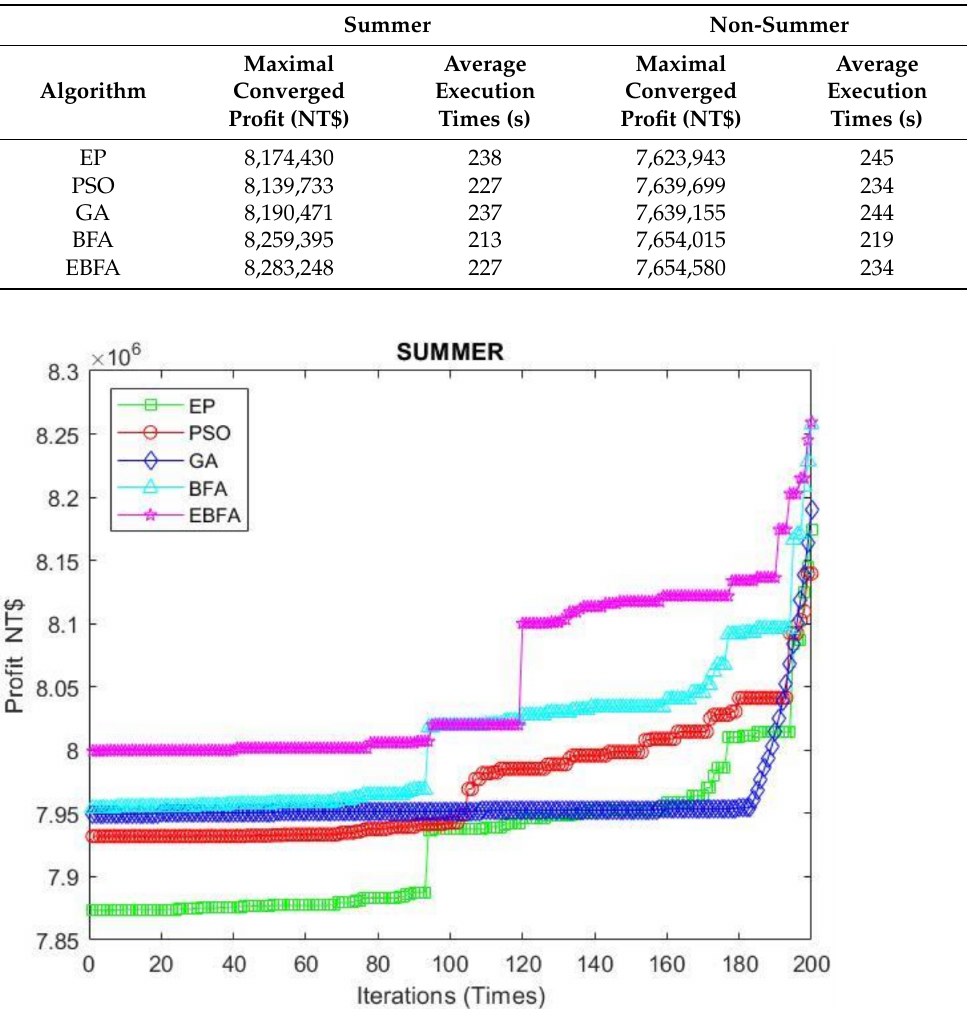
Figure 12. The convergence characteristics of EP, GA, PSO, BFA, and EBFA in